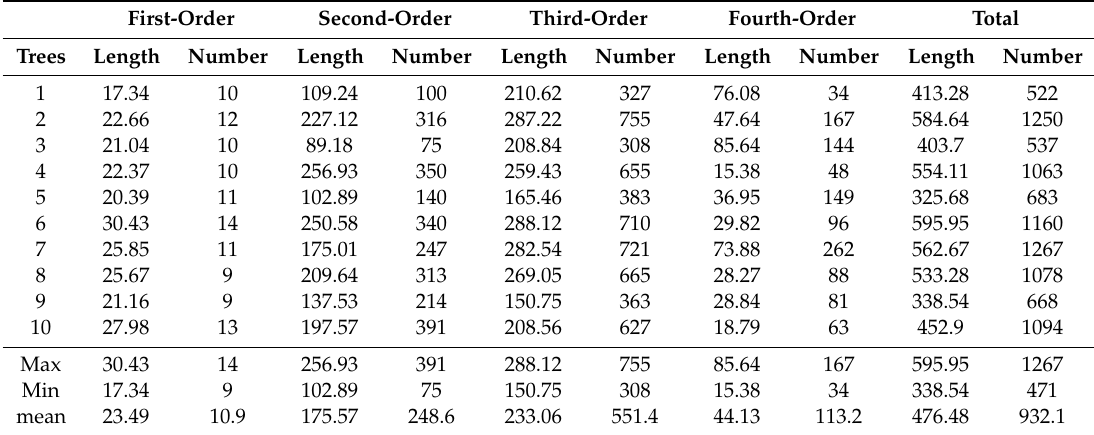
Table 1. In situ measured branches information of sample fruit trees. (Length unit: